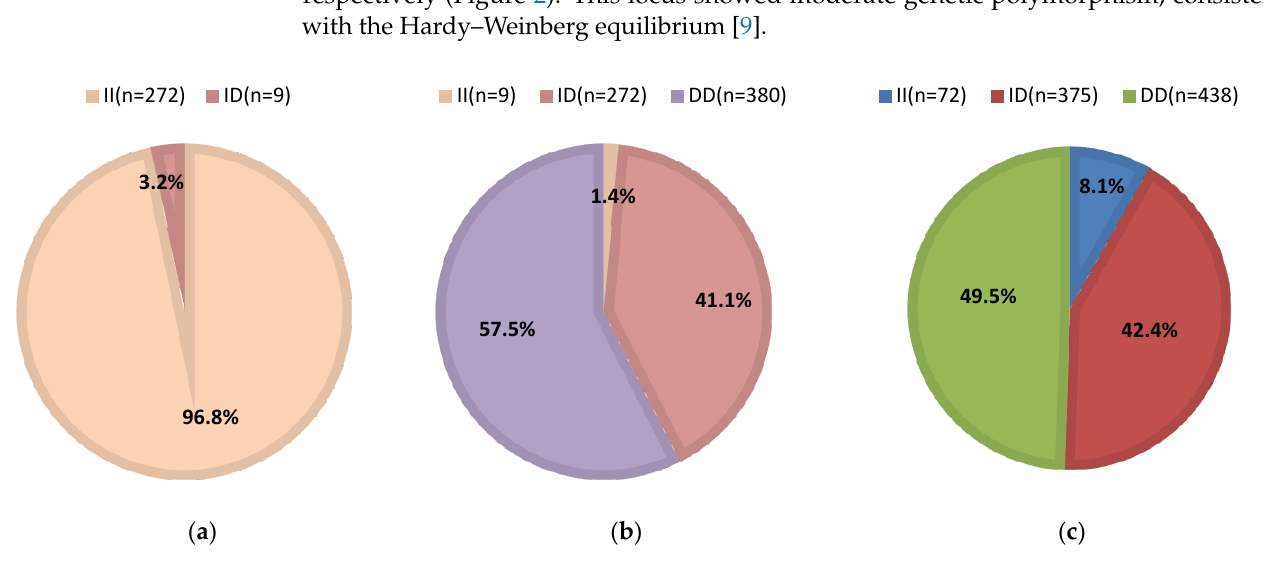
Figure 2. Pie charts of genotype frequencies for three InDel variant loci within the CFAP43 gene. ( a ) Genotype frequencies at the L-13 locus; ( b ) genotype frequencies at the L-16 locus; ( c ) genotype frequencies at the L-19 locus .